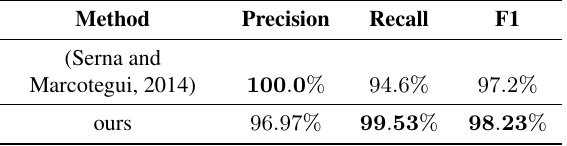
Table 6: Classification results for class “car” (in bold the best